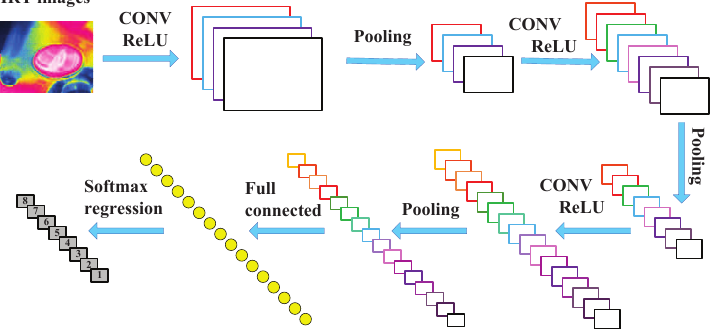
Figure 1. Architecture of the convolutional neural